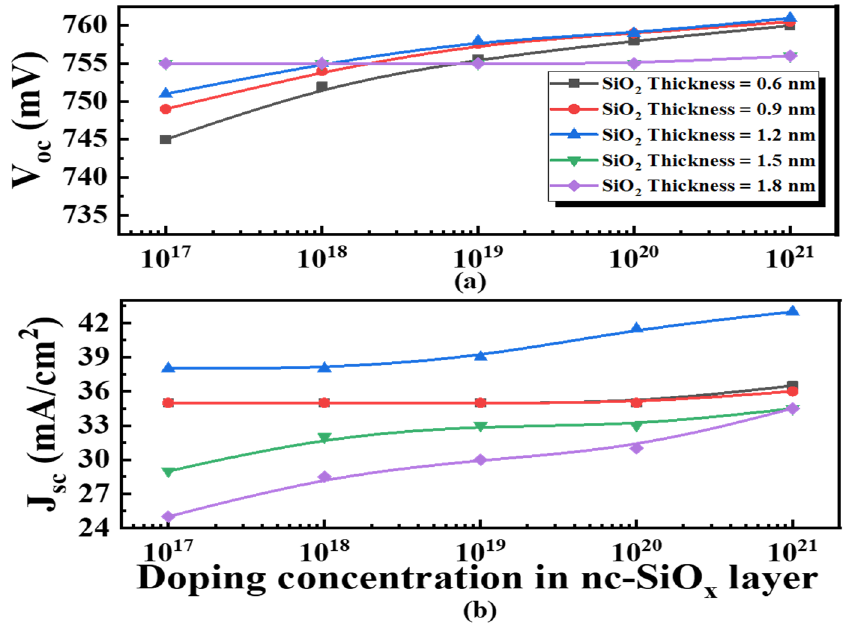
Figure 7. Effect of donor concentration (1 × 10 17 –1 × 10 21 cm − 3 ) with various oxide thicknesses (0.6–1.8 nm) on ( a ) V oc and ( b ) J sc on the TOPCon solar cell.